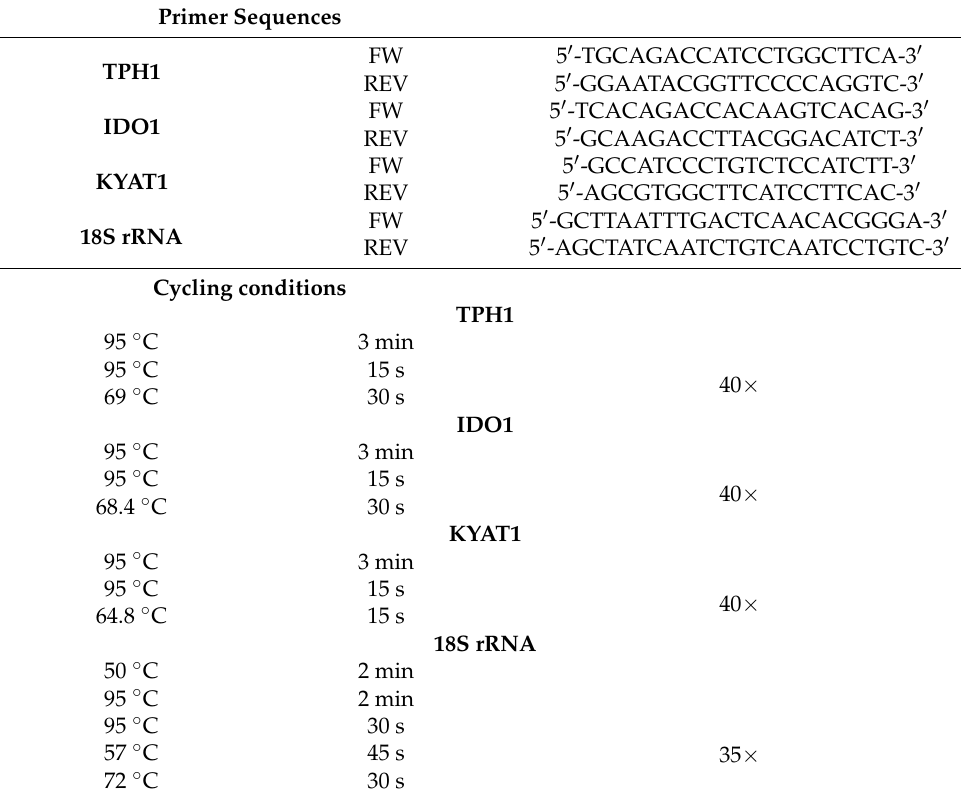
Table 4. Primer sequences and cycling conditions implemented in gene expression